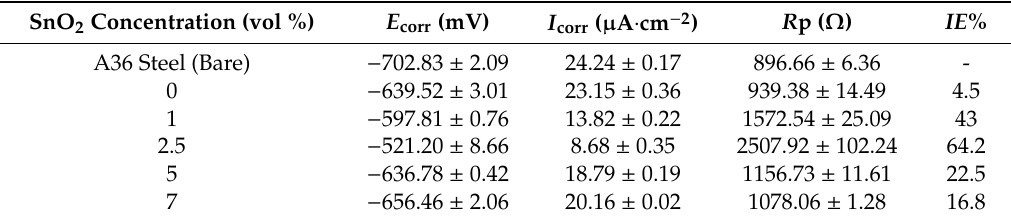
Table 2. The corrosion parameters obtained from polarization resistance measurements.